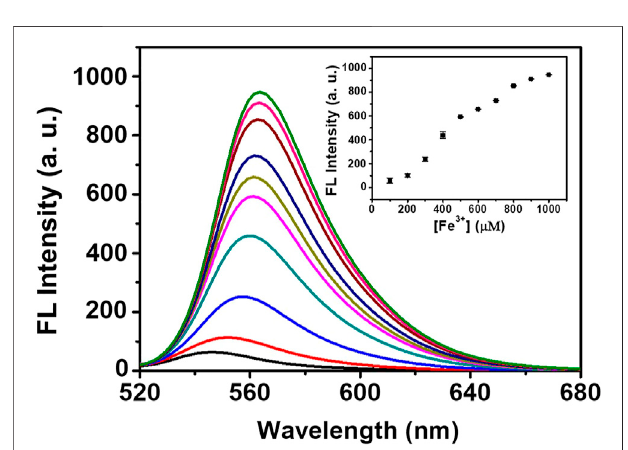
FIGURE 8 | Fluorescence spectra of DRF-PEG in diluted serum (10%) with different concentrations of Fe 3+ (100 – 1,000 μ M). The inset is the fl uorescence intensity as a function of [Fe 3+